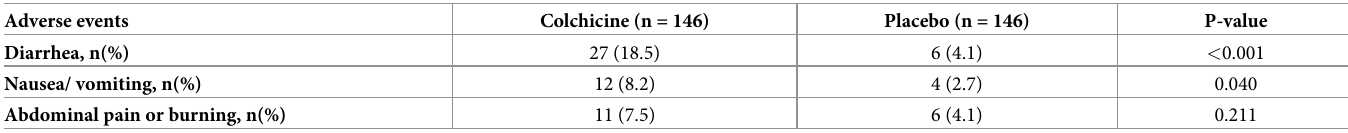
Table 3. Comparison of adverse events between colchicine and